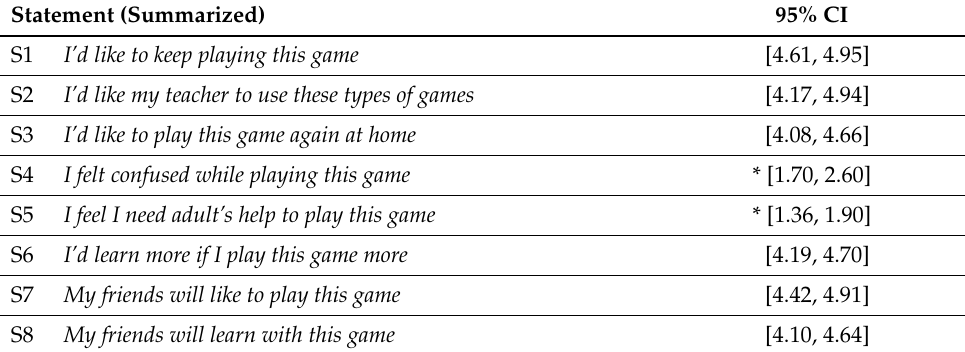
Table 5. 95% Confidence intervals (CI) for the results obtained with the Satisfaction and Usability Questionnaire, answered with a five-point Likert scale (from 1 to 5). Note that, in opposition to all other statements, the lower the values obtained for S4 and S5, the better. These are annotated with *.